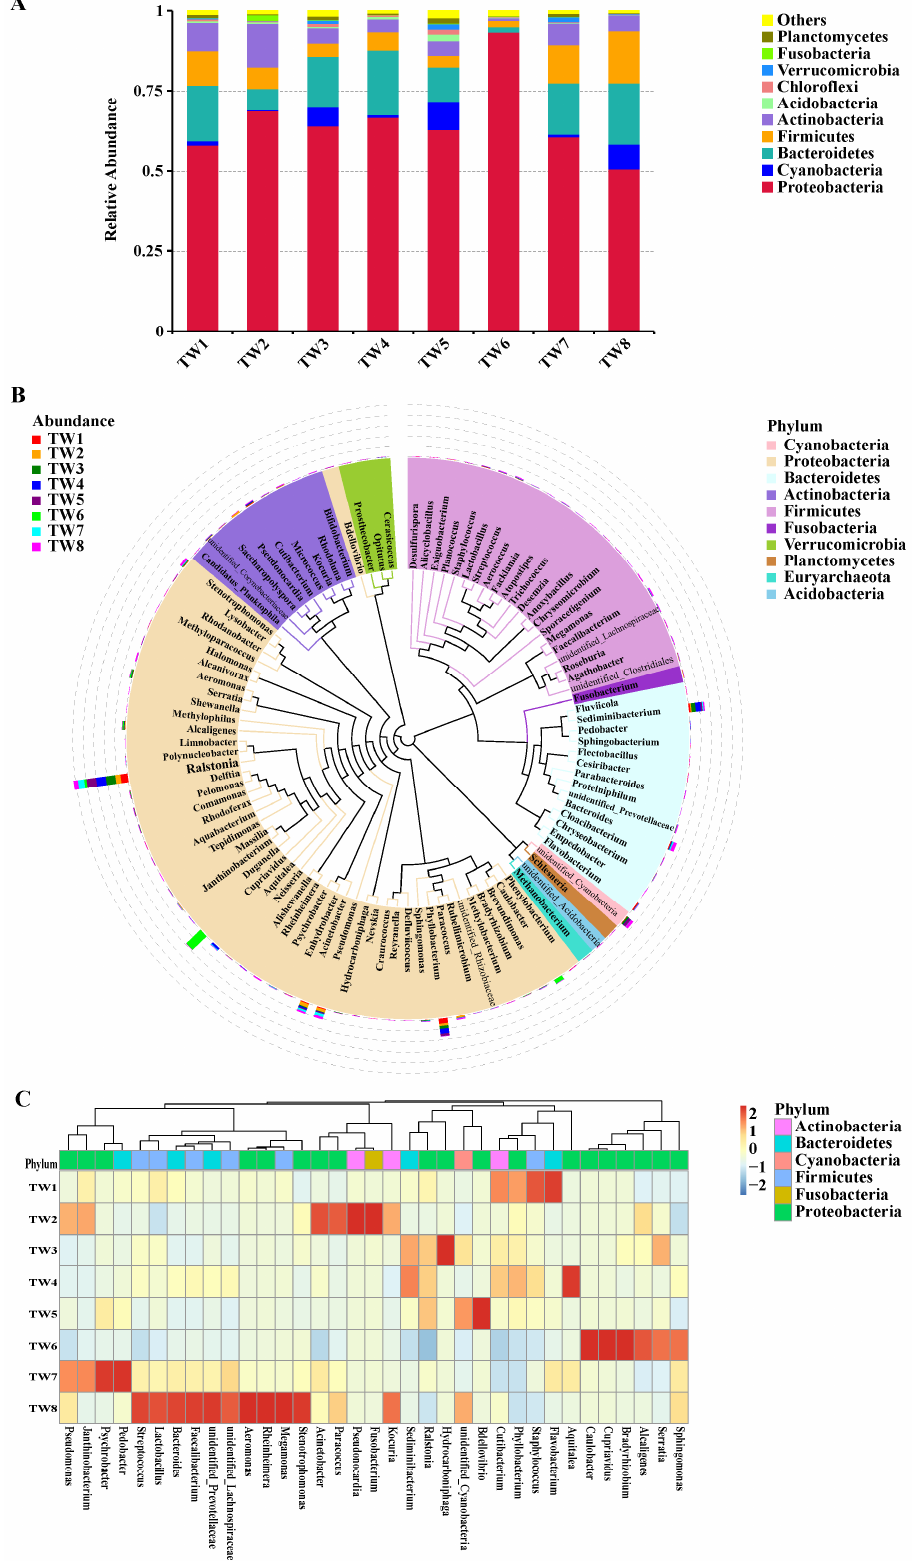
Figure 2. Composition and structure of water microbiota. ( A ) Columnar cumulative graph of the relative abundance of the top ten species of microbiota among the different groups at the phylum level; ( B ) The phylogenetic relationship of species at the genus level; ( C ) Cluster heat map of the composition abundance of the top 35 species of microbiota among different groups at the genus